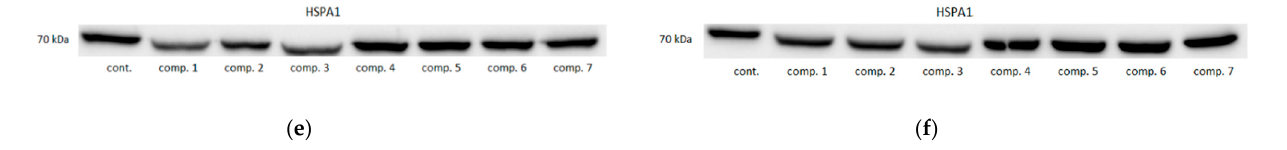
Figure 6. Effect of oxicams on HSPA1 protein expression in colorectal adenocarcinoma cell lines-exemplary blots: ( a ) in Caco-2 treated with 50 µM oxicams; ( b ) in Caco-2 treated with 200 µM oxicams; ( c ) in HCT 116 treated with 50 µM oxicams; ( d ) in HCT 116 treated with 200 µM oxicams; ( e ) in HT-29 treated with 50 µM oxicams; ( f ) in HT-29 treated with 200 µM oxicams. Cont., control; comp., compound.